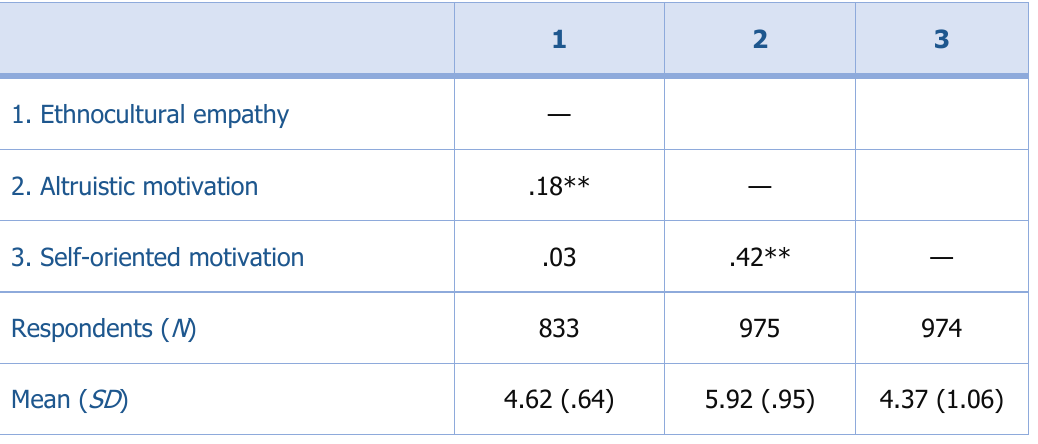
Table 1. Bivariate Correlations Between Ethnocultural Empathy and Volunteer Motivations